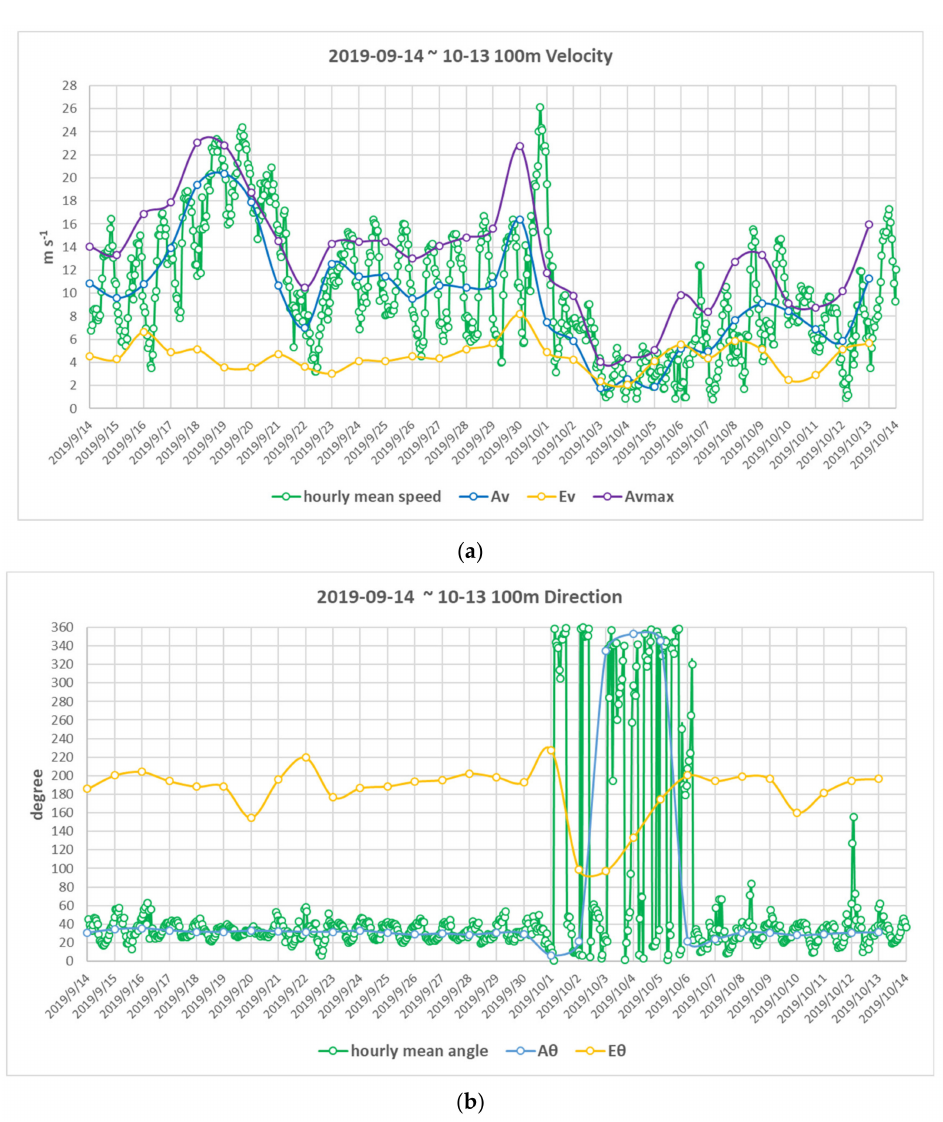
Figure 12. ( a ) Wind speed variation during 14 September–13 October 2019; ( b ) Wind direction variation during 14 September–13 October 2019. The green line is for the hourly mean wind vector. The blue line is for vector A. The yellow line is for vector E. The purple line is for the possible maximum wind vector of the